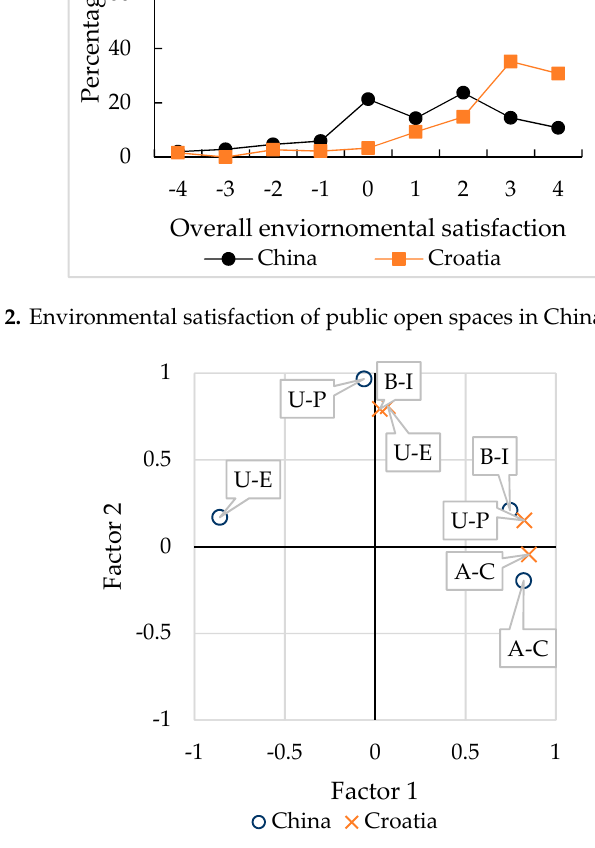
Figure 3. Component loading plot of soundscape descriptors for China and Croatia.